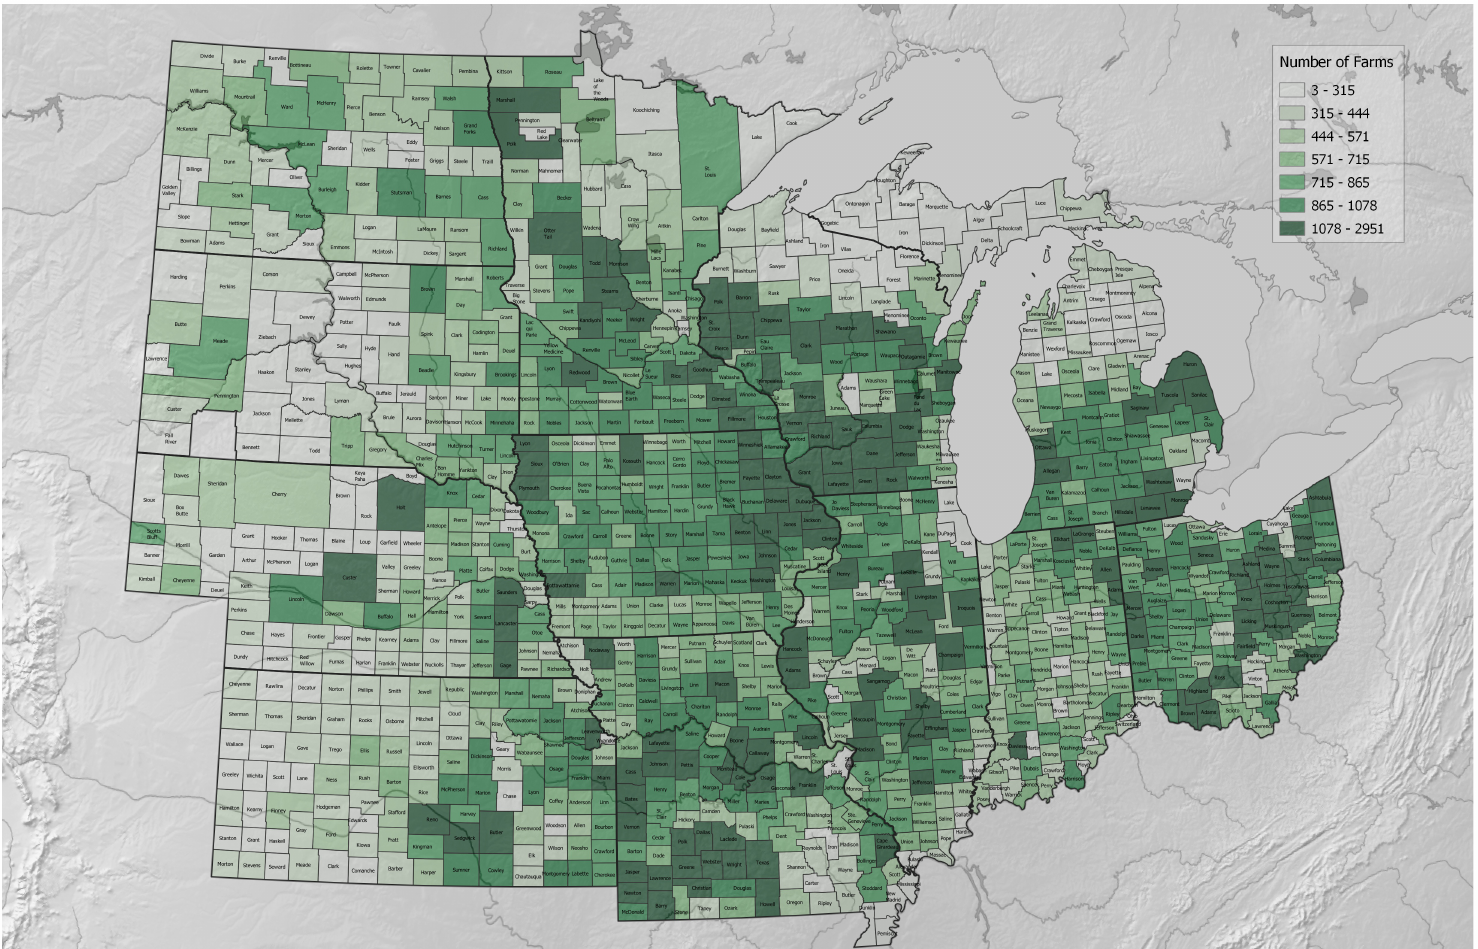
Figure A14. Number of farms per county, 2017. Methods for NumberOfFarms are described in the article main text and Supplementary Materials. USDA 2017 Census of Agriculture data [52] were